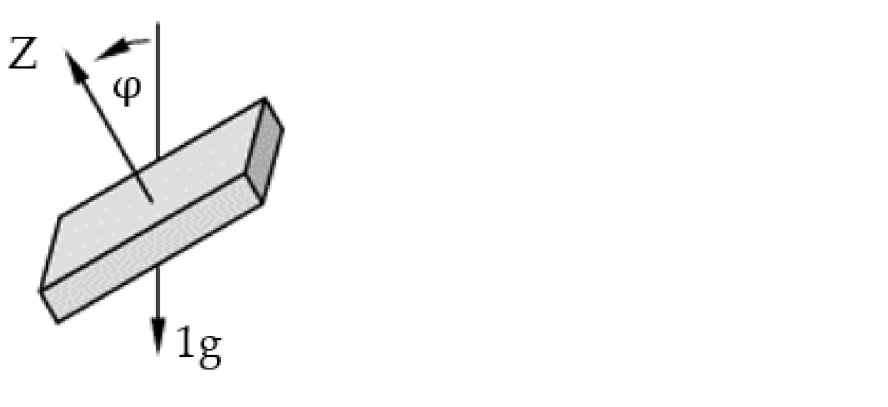
Figure 3. Angle of the sensor with respect to gravity in spherical coordinate